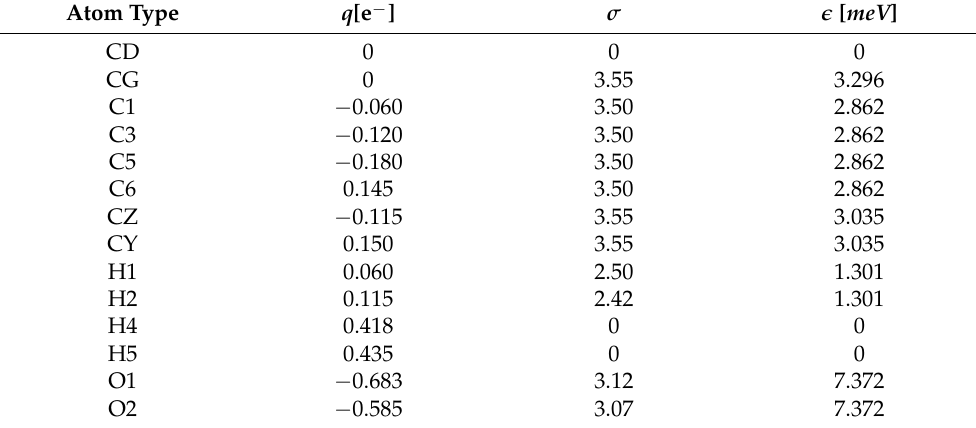
Table A5. Non-bonded parameters for Lennard-Jones interactions E LJ, ij = 4 (cid:101) ij [